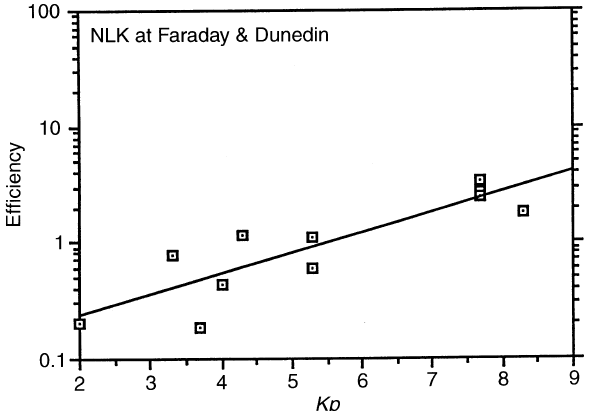
Fig. 5. As Fig. 4 but with NSS events from both Faraday and Dunedin